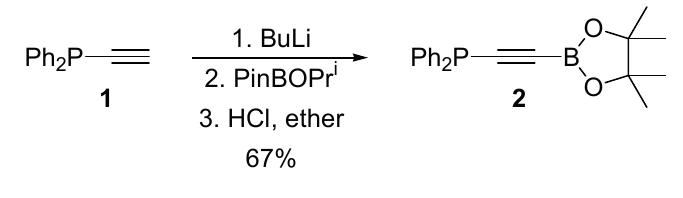
Figure 2. ORTEP diagram of alkyne 2 . H-atoms have been omitted for